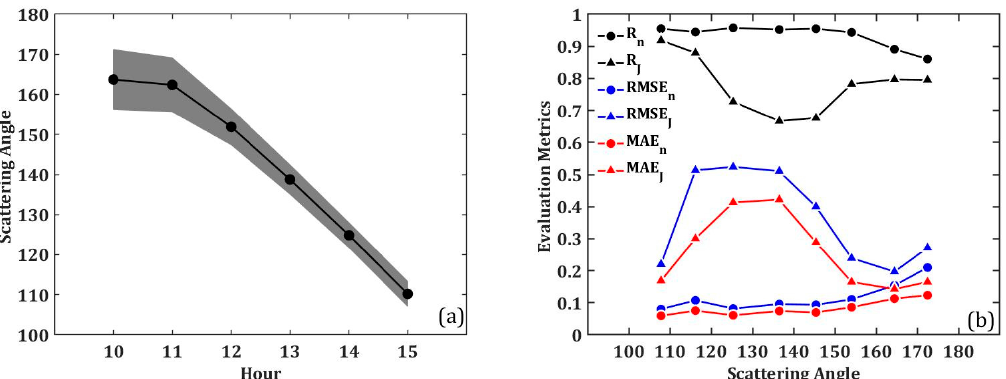
Figure 9. Diurnal variation of ( a ) AOD (550 nm) and ( b ) evaluation metrics. The subscript characters “n” and “J” denote the results for AOD-new and JAXA AOD, respectively.